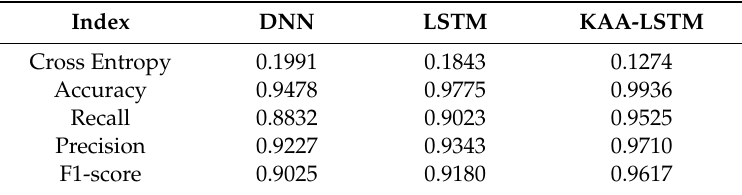
Table 1. The results of three comparative